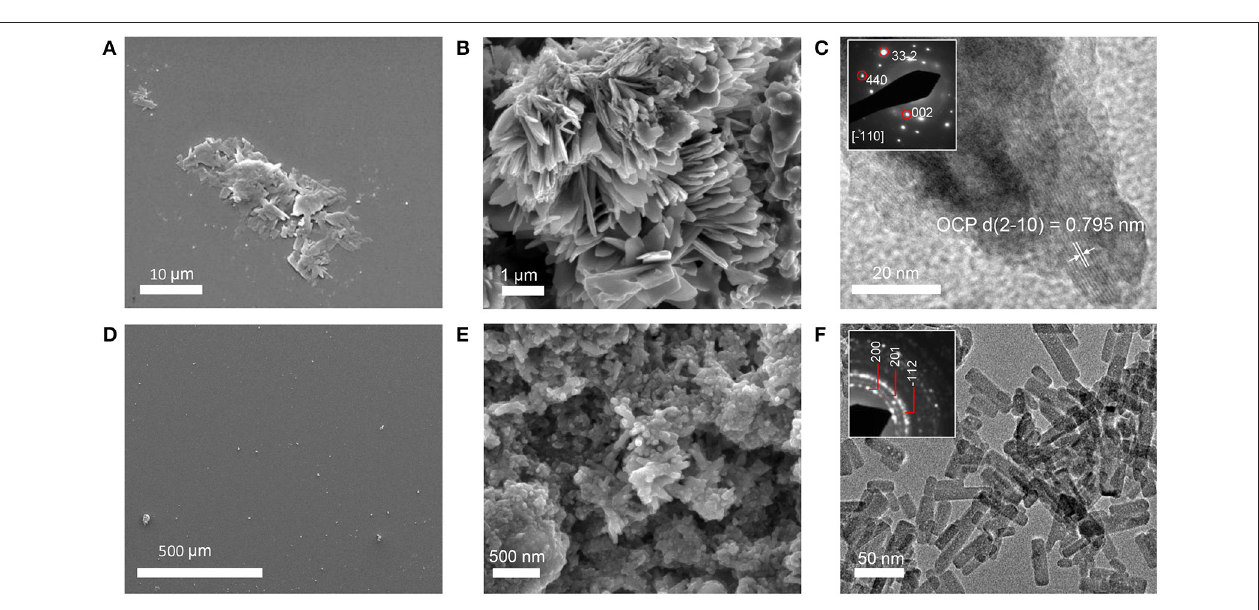
structures lead to the conclusion that the change in mineral chemistry and morphology observed between the 3 h and 8 day period, coupled with the etch marks on the brushite surface, occurred due to a dissolution and re-precipitation process. The re-precipitated FAp crystallites were templated by the original brushite crystal, forming a layered ordered